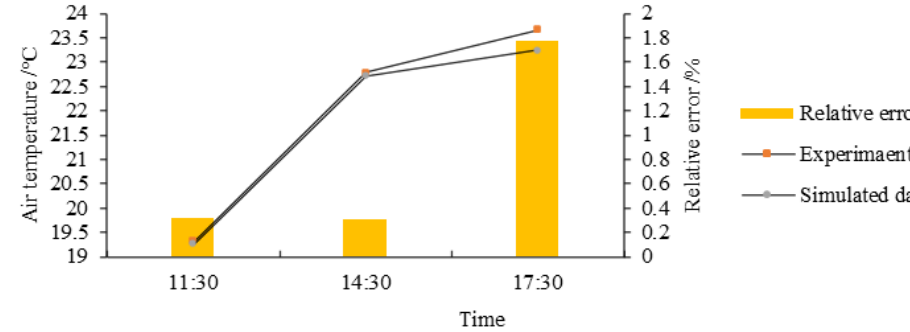
Figure 9. Comparisons of measured and simulated indoor air temperature.